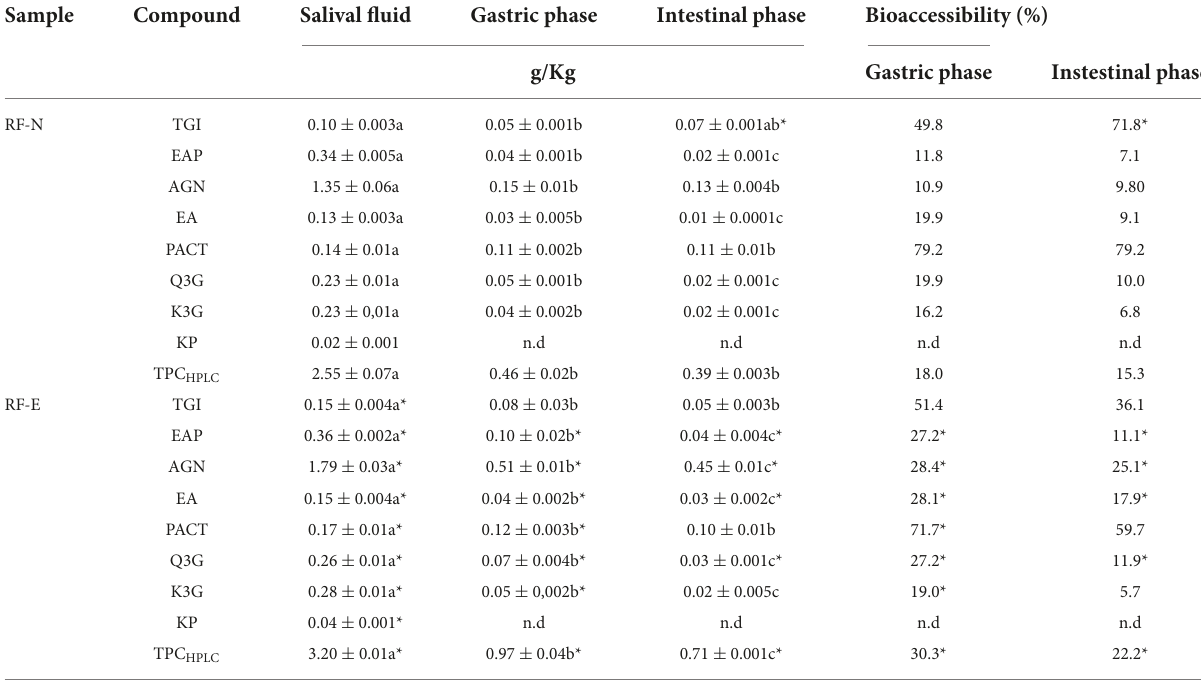
TABLE 3 Bioaccessibility of strawberry by-products (RF) phenolic compounds.